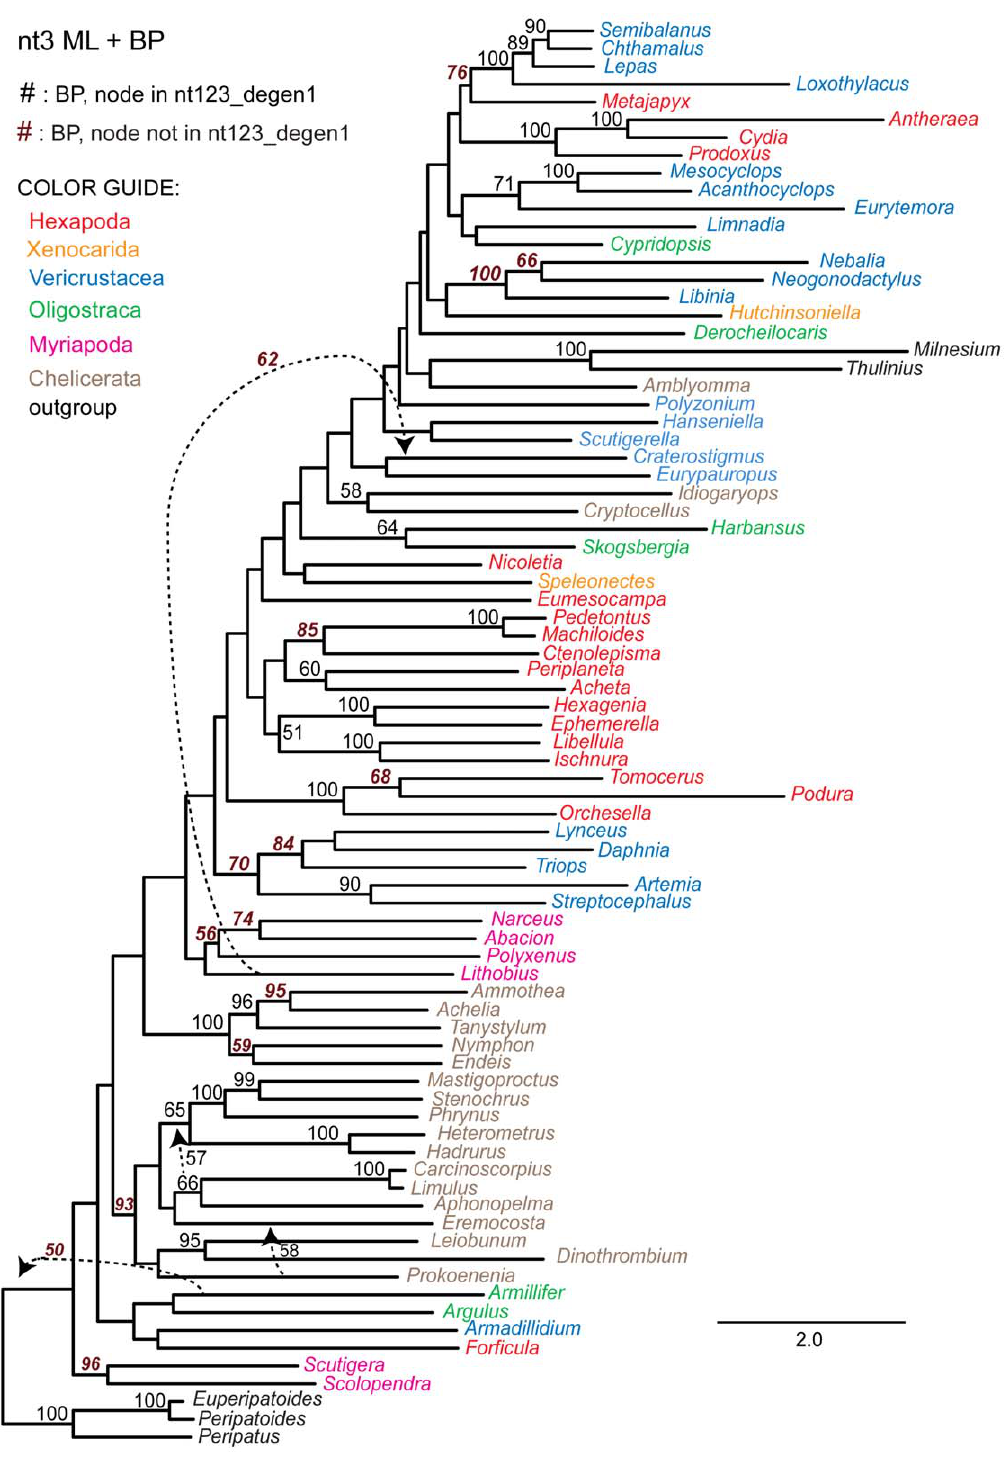
Figure 6. Phylogram derived from likelihood analysis of the nt3 character coding of the 68 gene segments. Bootstrap values $ 50% are displayed above internal branches. All and only those bootstrap percentages that correspond to nodes not present in the nt123_degen1 topology (Figure 1) are in italics, boldface, and brown in color. Notice that the branch lengths for the degenerated data matrix nt3_degen1 (Figure 6) are much shorter than in this figure. Units are substitutions / character. doi:10.1371/journal.pone.0023408.g006 dominant feature of characters undergoing synonymous than across the entire data set. While there is increasing interest in nonsynonymous change [25–28,5]. The likelihood models that we modeling compositional heterogeneity, it is still a work in progress have used assume a single nucleotide composition, biased or not, [53–56]. The current methodological inadequacy can be seen as